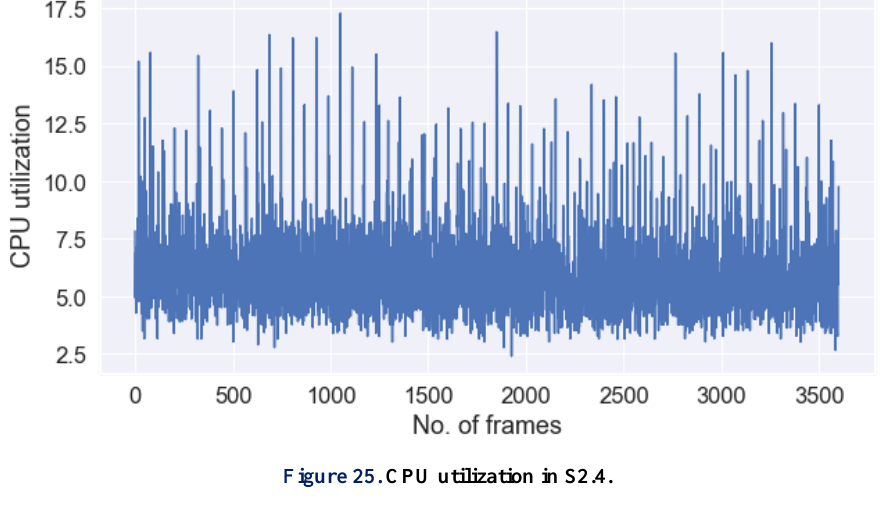
Figure 25. CPU utilization in S2.4.